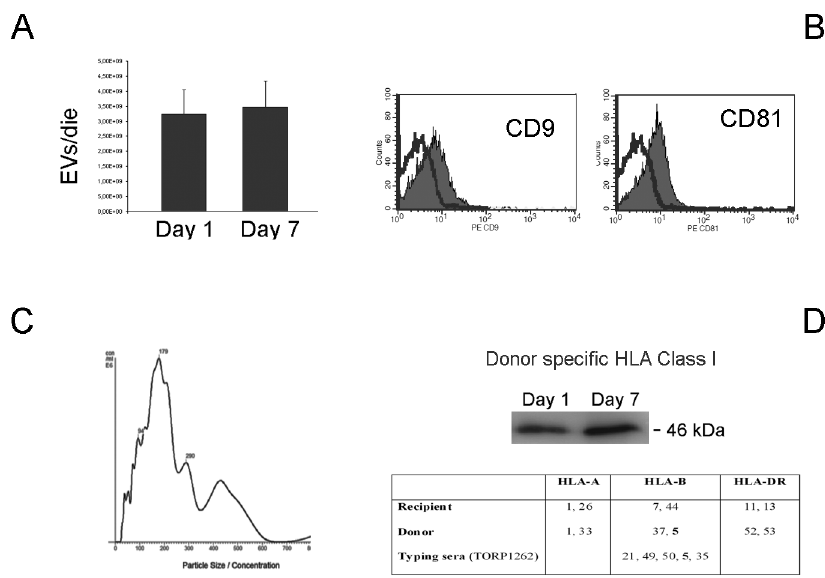
Figure 3. Characterization of urinary EVs in transplanted patients. Urinary EVs were obtained from patients (n=25) undergoing renal transplant. Panel A . Mean number of EVs/day in the urine of transplanted patients were similar at day 1 and 7 after transplant, counted as described in Material and Methods. Data are mean 6 SD of all samples. Panel B and C . Characterization of EVs showing expression of CD9 and CD81 exosome markers and NanoSight analysis of size distribution profile. Similar results were obtained for samples from all transplanted patients at day 1 and 7. Panel D . Representative western blot analysis showing the donor origin of the extracellular vesicle using typing sera containing antibodies directed against HLA class I antigens of the donor not shared by the recipient, at 1 and 7 days after transplant. In the table are reported the HLA typing of the recipient and the donor and the HLA-antigen recognized by the typing serum (TORP1262). HLA-B5 (bold) is present in the donor and not in the recipient. Three patients were tested with similar